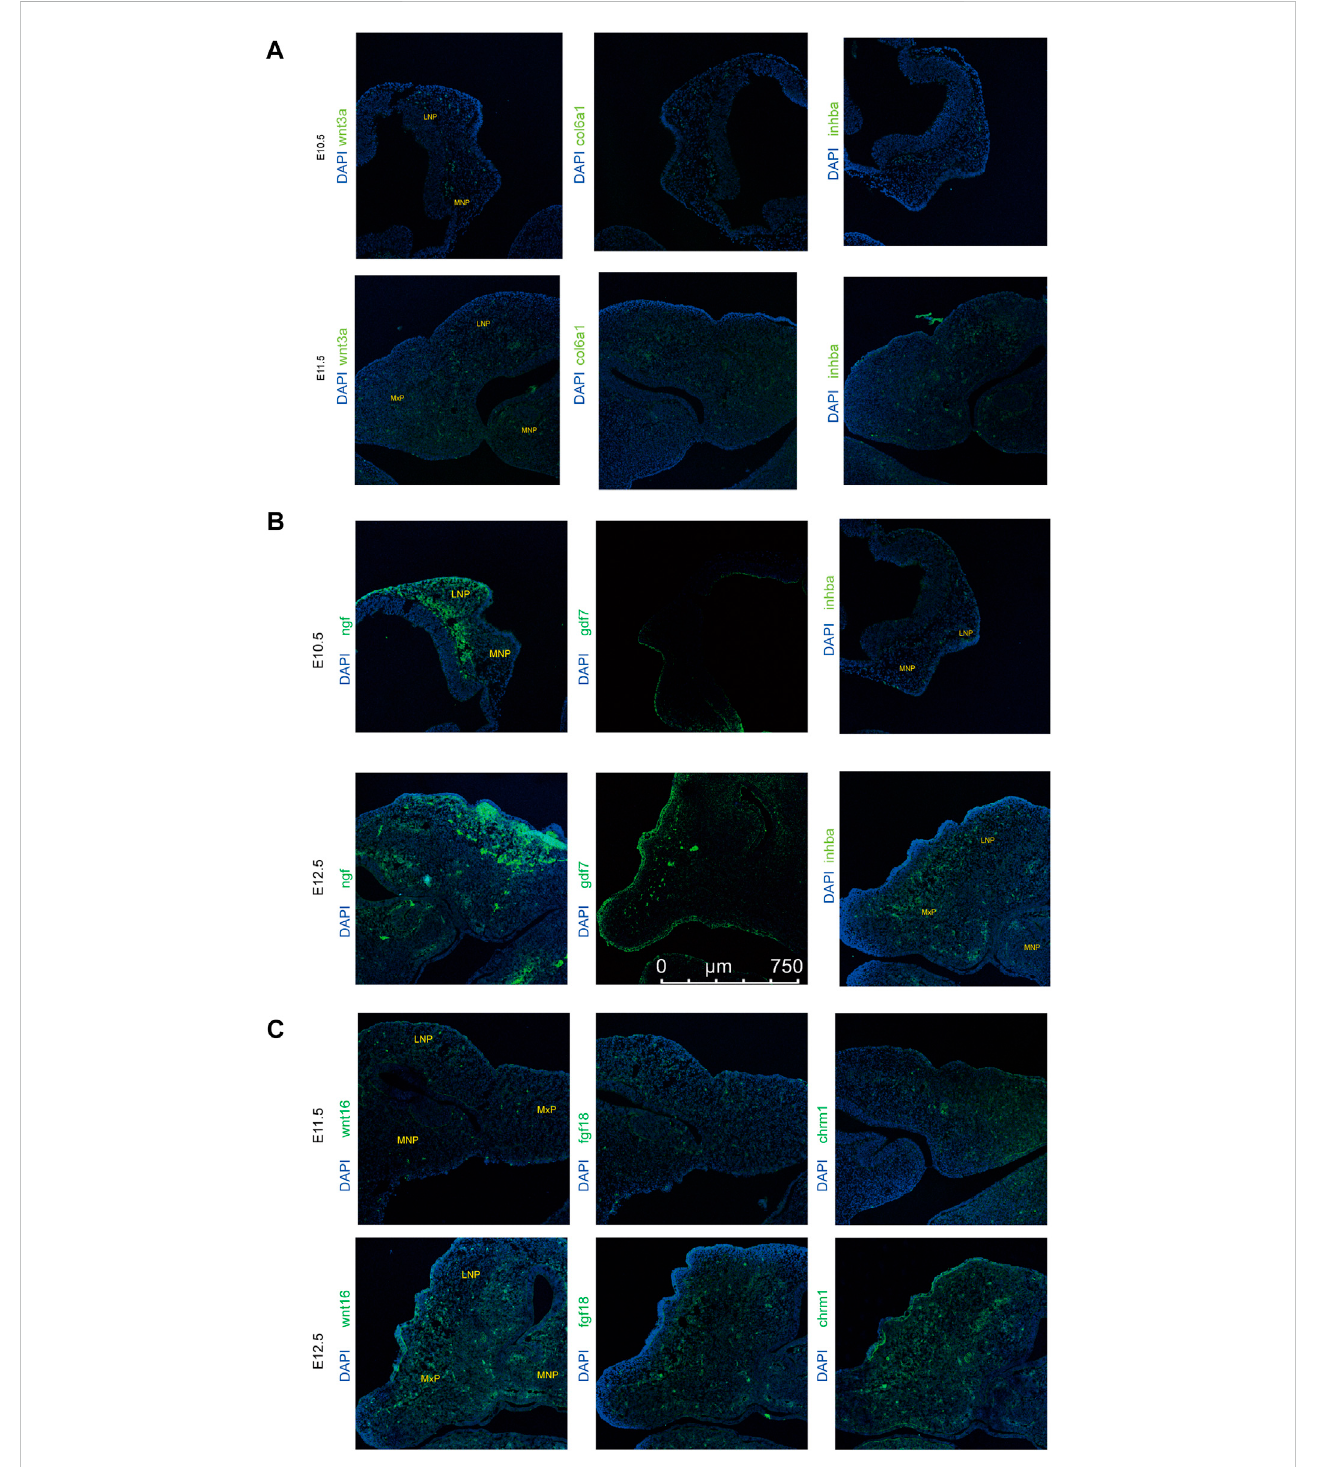
FIGURE 5 xpression levels of representative genes from the signal-gene network detected by immuno fl uorescence in lambdoidal junction tissues of mice at embryonic days 10.5, 11.5, and 12.5. (A) Expression levels of wnt3a, col6a1, and inhba between E10.5 and E11.5. (B) Expression levels of wnt16, fgf18, and chrm1 between E12.5 and E11.5. (C) Expression levels of gdf7, inhba, and ngf between E12.5 and E10.5. MxP: maxillary prominence; LNP: lateral nasal; MNP, medial